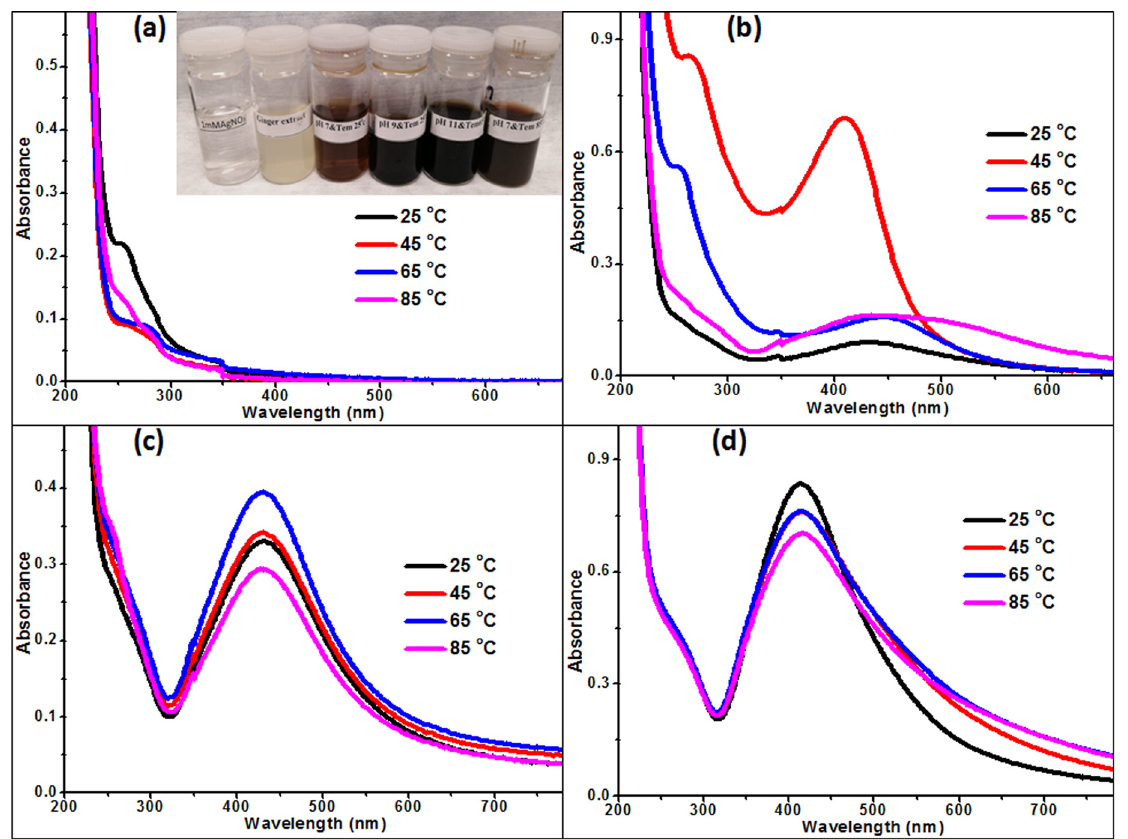
Figure 1: UV - Vis spectra of ginger - synthesized AgNPs at di ff erent pH and temperature ( a ) at pH 5, ( b ) at pH 7, ( c ) at pH 9, and ( d ) at pH